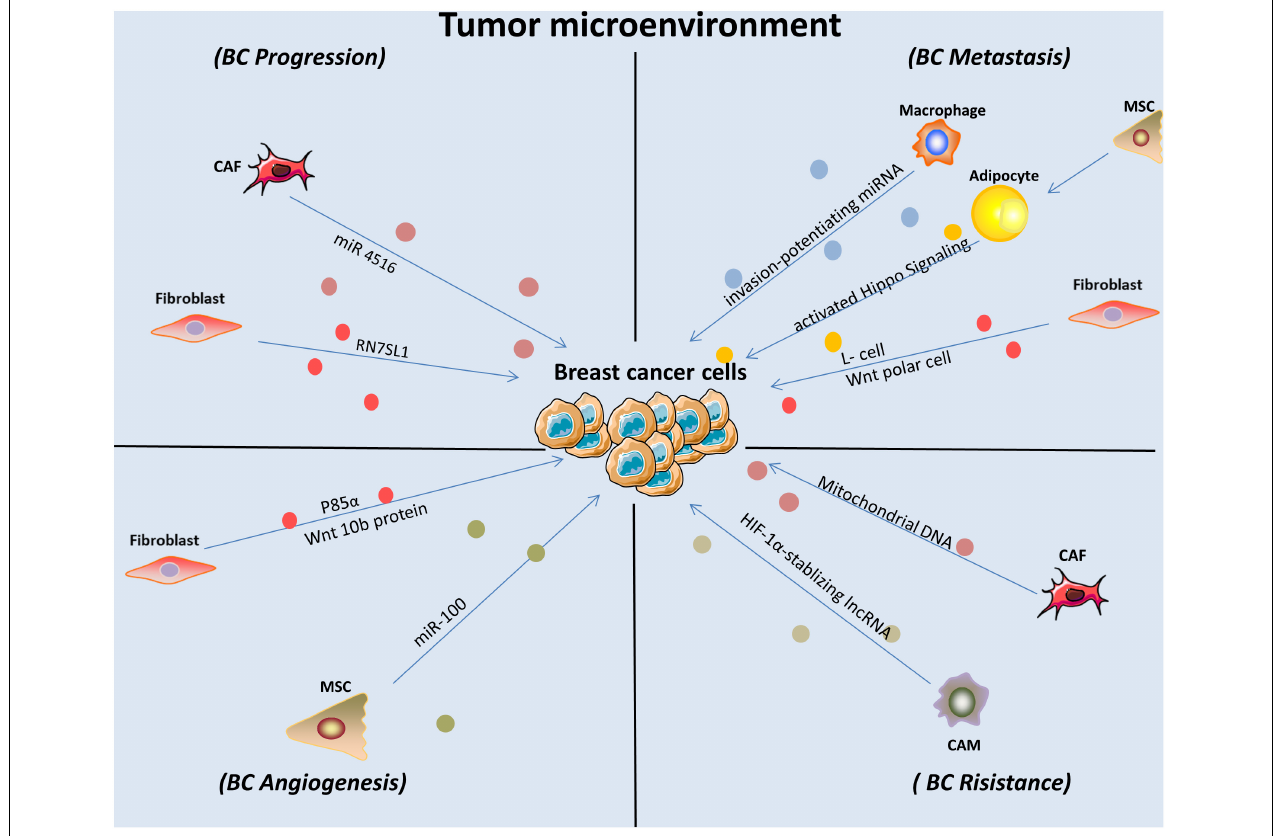
FIGURE 2 | Exosomes derived from stromal cells affected BC cell behaviors and contributed to enhanced malignant progression. CAM, cancer associated macrophage; MSC, mesenchymal stem cells; CAF, cancer associated